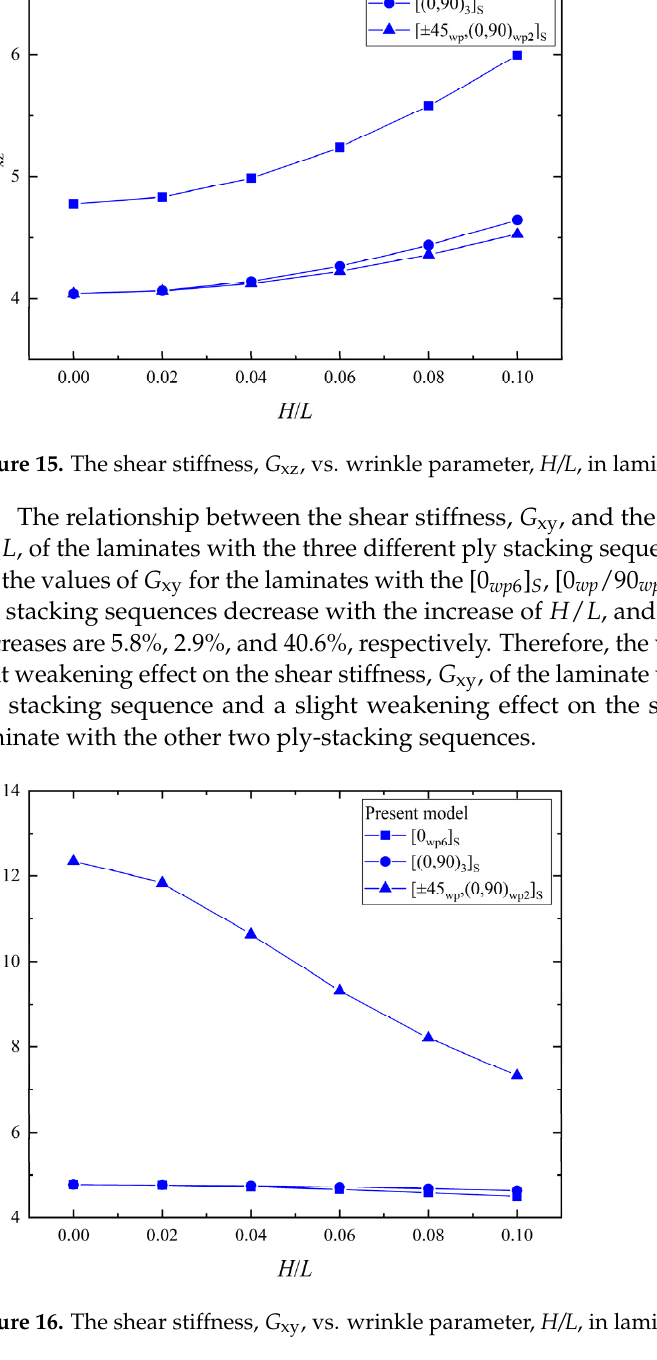
Figure 16. The shear stiffness, G xy , vs. wrinkle parameter, H/L , in laminates.